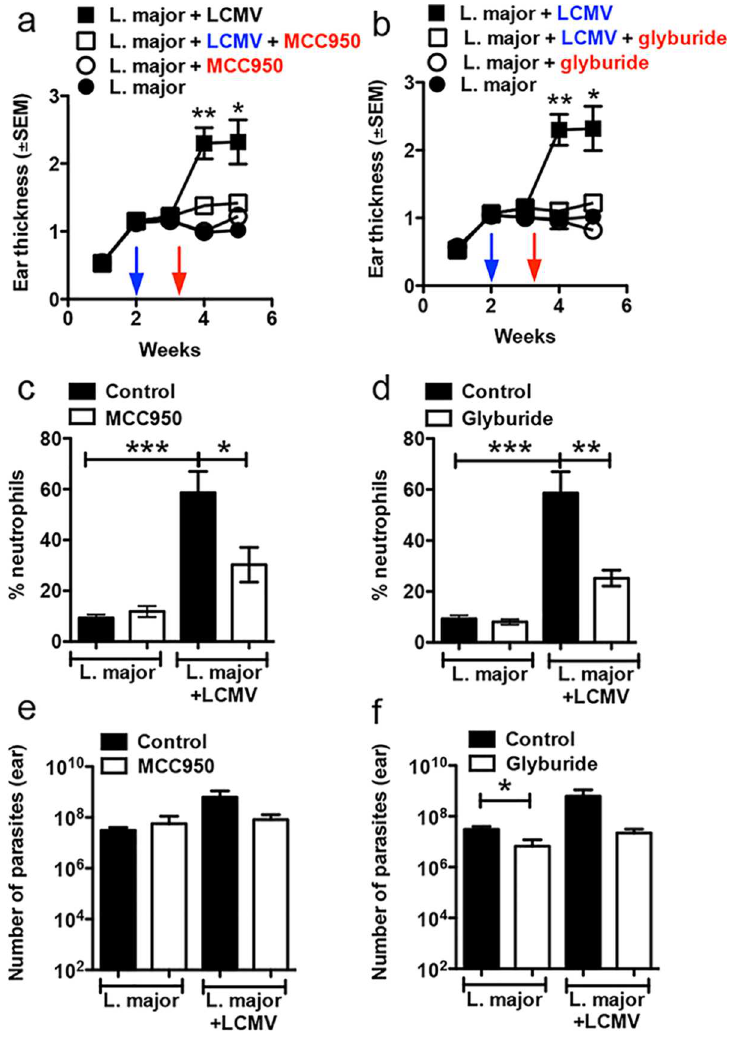
Fig 4. Treatment of mice with NLRP3 inhibitors dampens the immunopathology caused by CD8 T cells. WT C57BL/6mice were infected with L . major in the ear, and 2 weeks later mice were co-infectedwith 2 × 10 5 PFU of LCMV Armstrong strain by i.p. injection. Ten days post LCMV infectionmice were treated with MCC950,glyburideor vehicle; (a and b) ear thickness was assessedweekly. Five weeks post infectionwith L . major , mice were euthanized and the lesionswere digestedand the (c and d) frequency of neutrophilsin the skin was determined directly ex vivo by flow cytometry. (e and f) Number of parasites in the skin was determined at 5 weeks post infectionwith L . major . Results in mice are data from one experiment with 5 mice per group. * p (cid:20) 0 . 05 , ** p < 0 . 01 or *** p (cid:20) 0 .